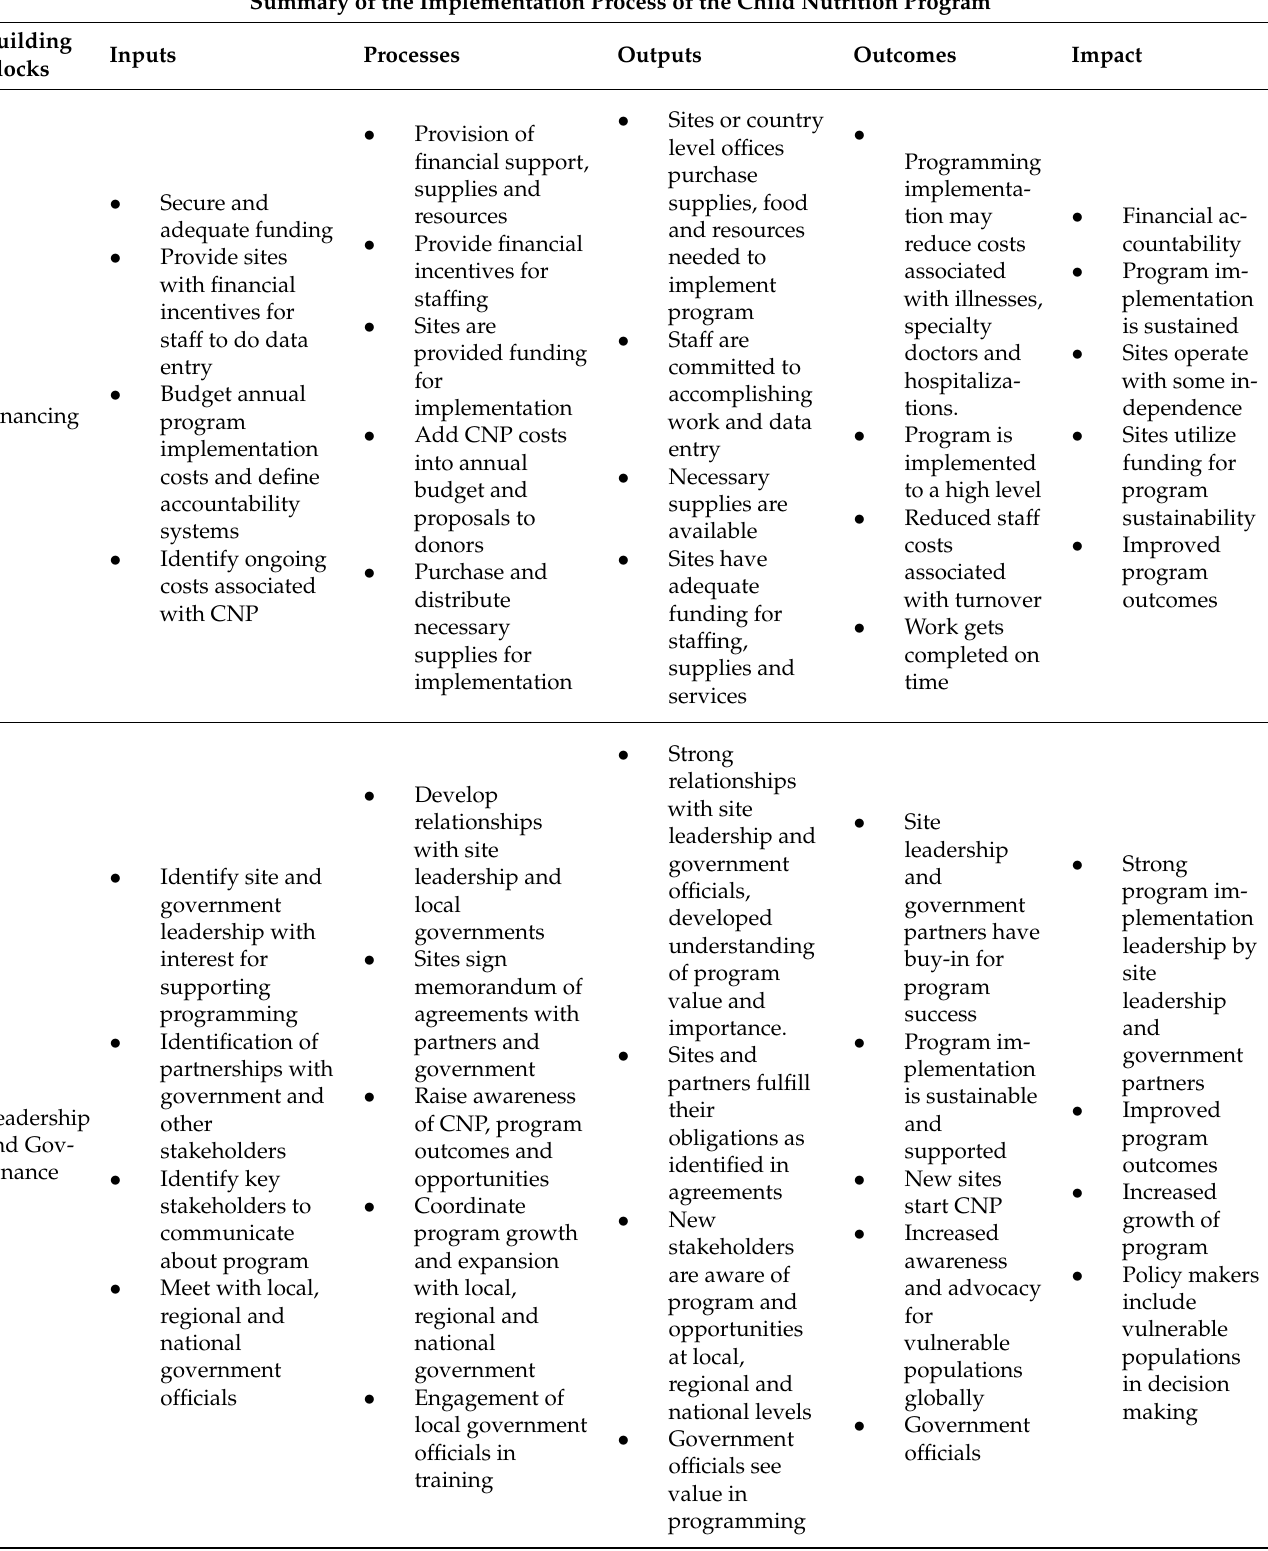
Table A3. Cont. Summary of the Implementation Process of the Child Nutrition